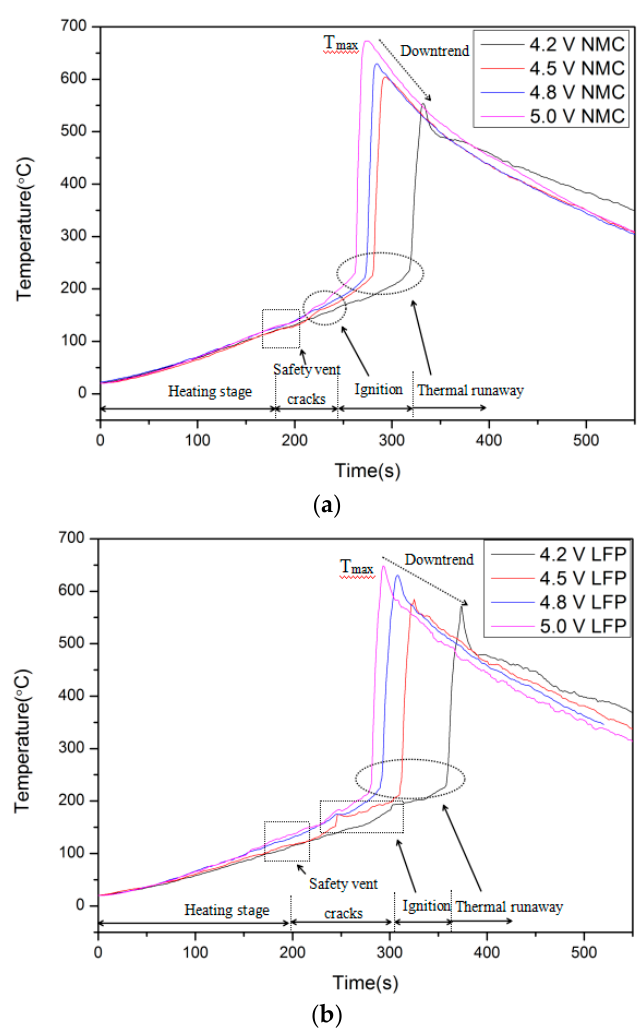
Figure 7. The typical curves of LIB surface temperature during tests: ( a ) NMC; ( b ) LFP.